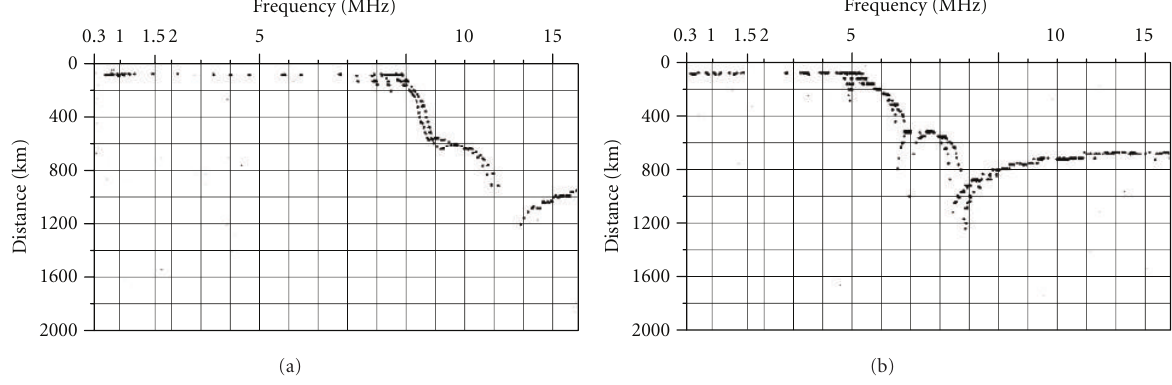
Figure 11: IK-19 satellite topside ionogram (from Karpachev et al. [52]) recorded: (a) at 23:16 UT (15:40 LT) on 25 November 1980 at the MLat − 4.9 ◦ and longitude 245 ◦ E, (b) at 16:04 UT (07:00 LT) on 7 September 1980 at MLat 0.8 ◦ and longitude 223.3 ◦ E.